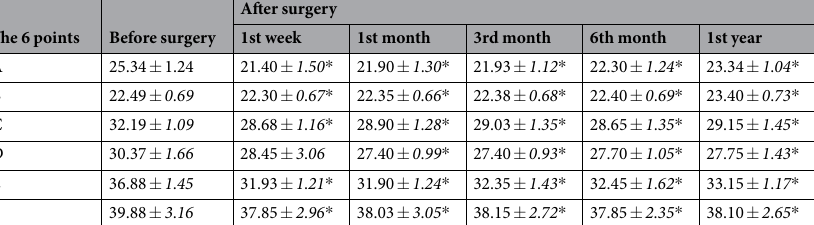
Table 1. The circumference of the affected upper limb after lymphatic TRAM/DIEP ( x ± s, cm). Abbreviations: (A) The part of the hand between the thumb and the index finger; (B) wrist; (C) the median of the forearm; (D) elbow through olecranon; (E) the median of the upper arm; (F) the root of the upper arm. * p < 0.05, based on a paired t-test.